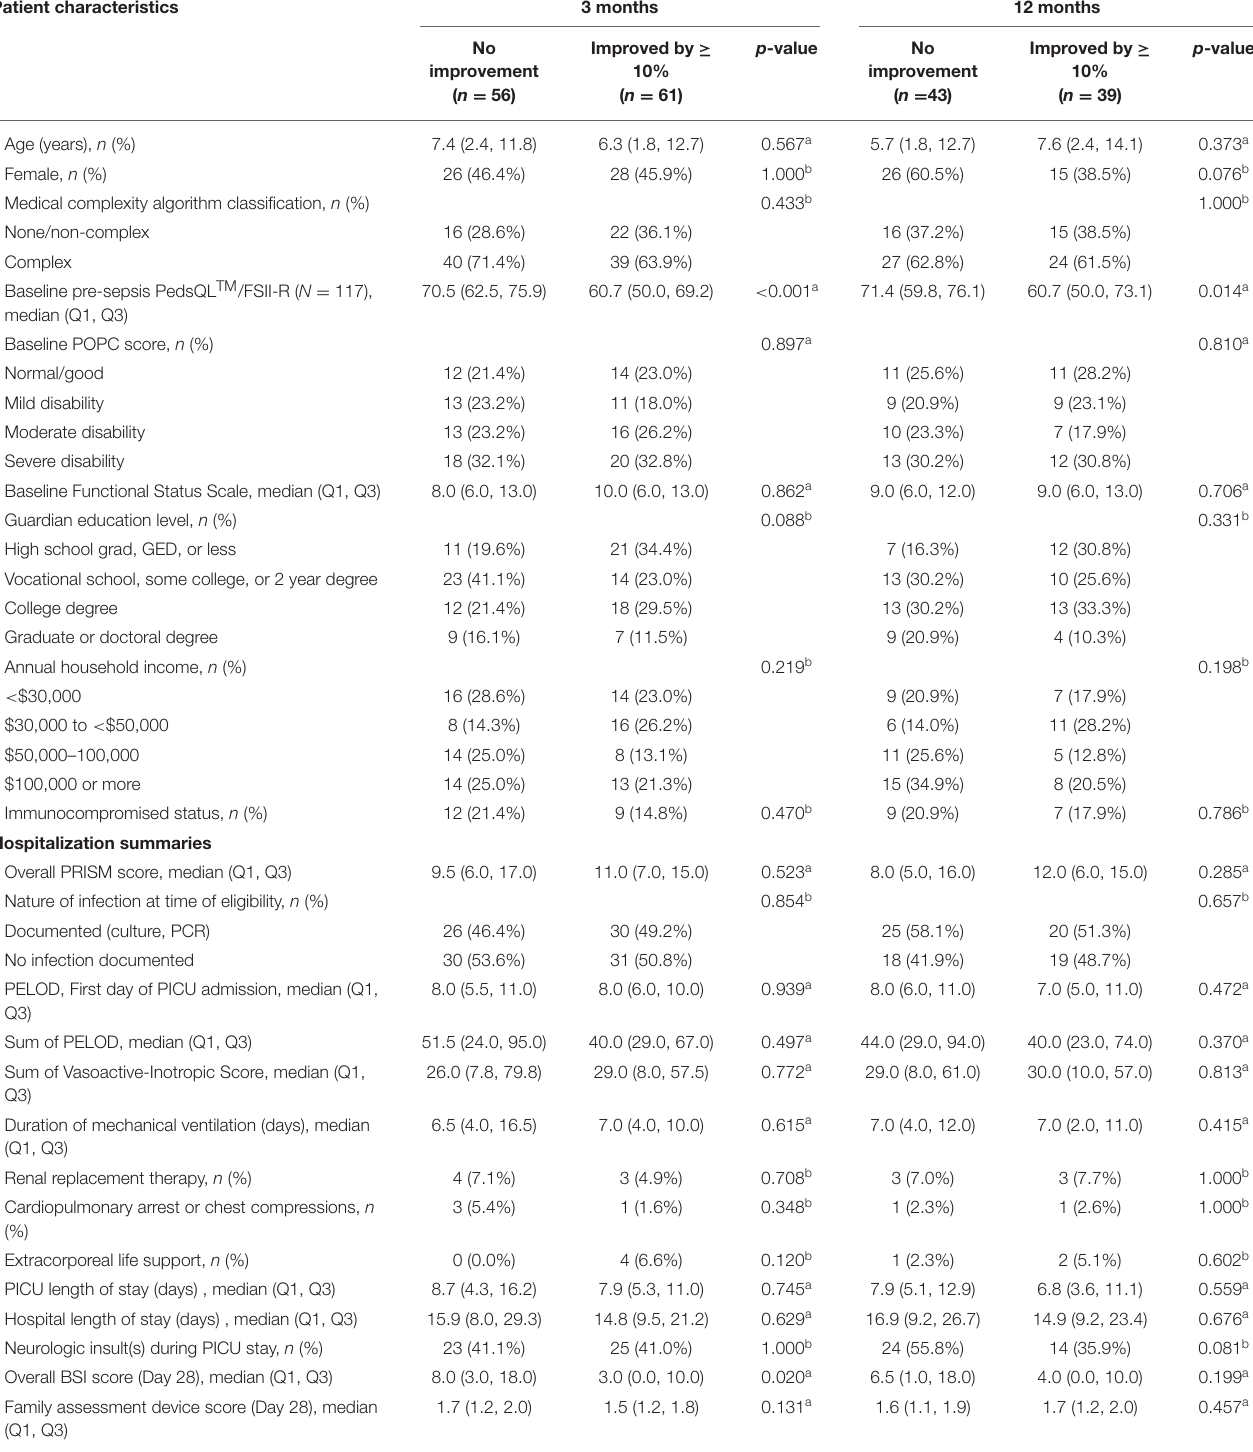
TABLE 2 | Patient and hospitalization characteristics by improvement status at 3 and 12 months. Patient